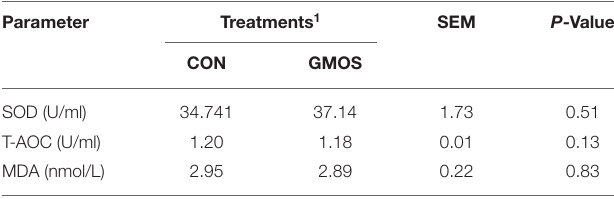
TABLE 5 | Effects of dietary supplementation of GMOS on serum antioxidant indexes of goats. Parameter Treatments 1 SEM P -Value CON